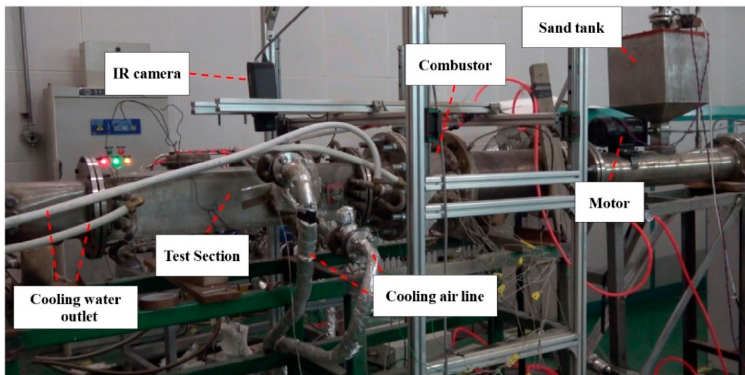
Figure 2. Photograph of the turbine deposition facility.